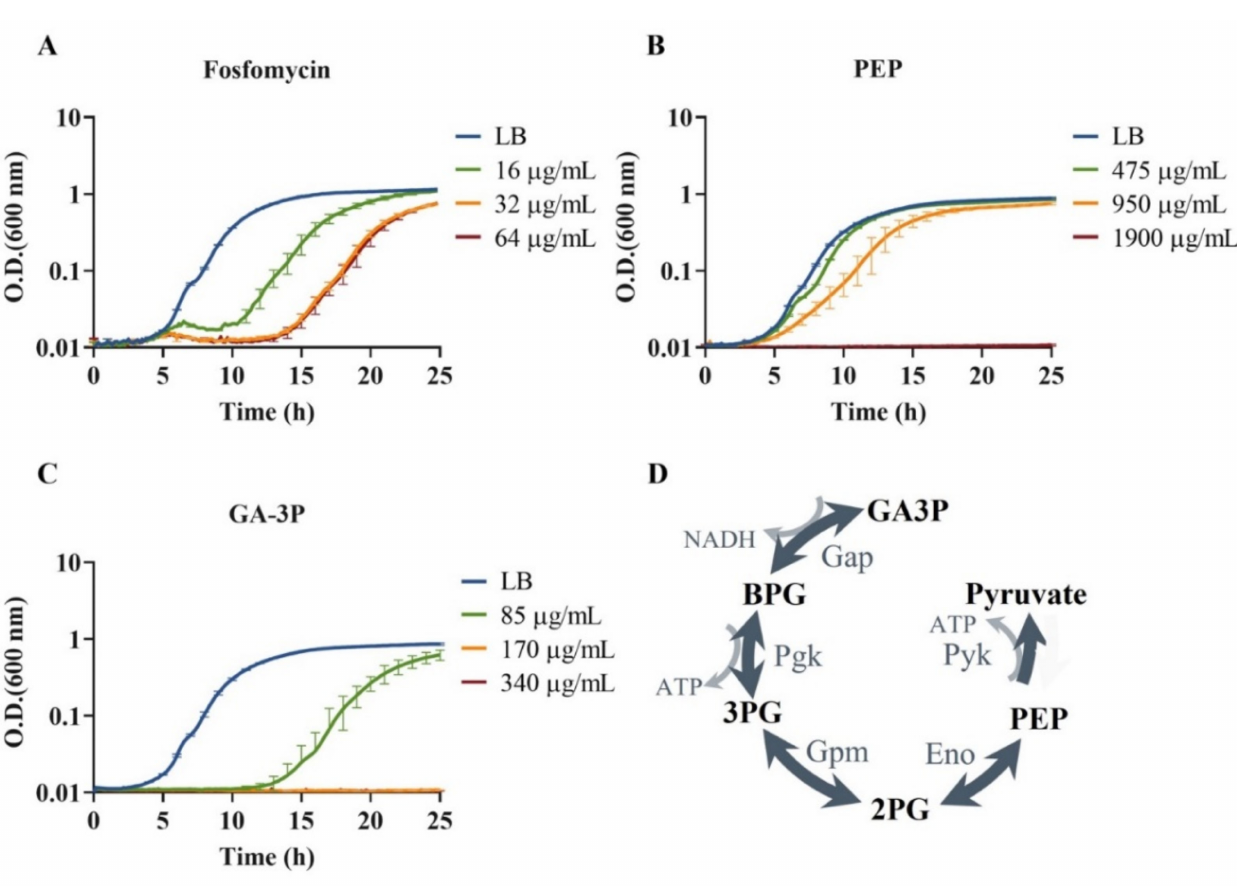
Figure 1. Effects of ( A ) fosfomycin, ( B ) PEP, and ( C ) GA-3P on the growth of S. maltophilia D457 in LB medium. Growth curves were measured in the presence of different compounds’ concentra- tions, and growth in LB medium was used as a control. Error bars indicate standard deviations for the results from three independent replicates. Panel ( D ) shows the metabolic pathway where previously identified mutations leading to fosfomycin resistance in S. maltophilia are located